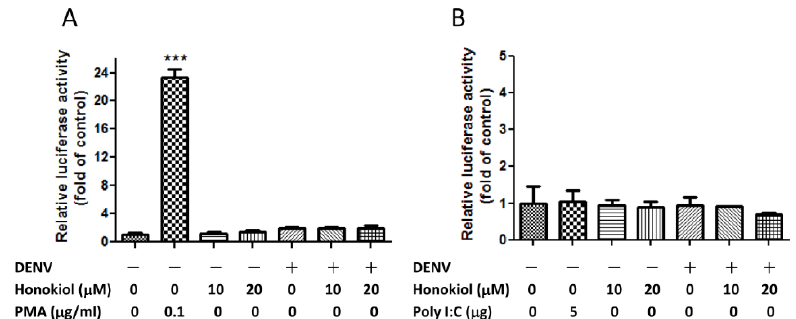
Figure 7. Honokiol does not alter the activation of NF-κB and the expression of IFN-β. ( A ) Assay of NF-κB activation. Huh7 cells transfected with NF-κB-luciferase reporters were mock or infected with DENV at MOI = 5 and then treated with honokiol at 10 and 20 μM for 48 h, followed by Firefly-Renilla luciferase assay to determine the relative expression of NF-κB responsive luciferase. PMA is an NF-κB activator and was used as a positive control; ( B ) Assay of IFN-β promoter activity. Huh7 cells transfected with IFN-β-luciferase reporters were mock or infected with DENV at MOI = 5 and then treated with honokiol at 10 and 20 μM for 48 h, followed by Firefly-Renilla luciferase assay to determine the relative expression of IFN-β promoter-driven luciferase. Poly(I:C) is a immunostimulant similar to dsRNA and was used as a control. Data indicate the average value of triplicates (mean ± SD). *** p < 0.001 as compared with the control.